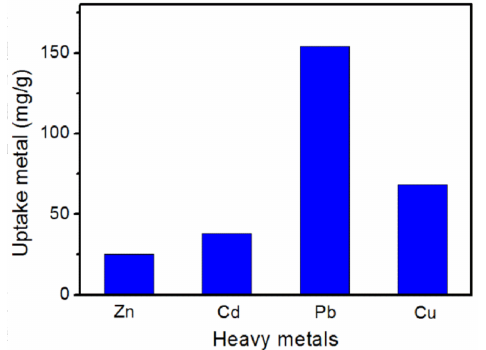
Figure 11. Effect of the presence of competitor ions on adsorption of Pb(II) (Reaction conditions: contact time t = 120 min, pH = 5.5, T = 30 ◦ C).